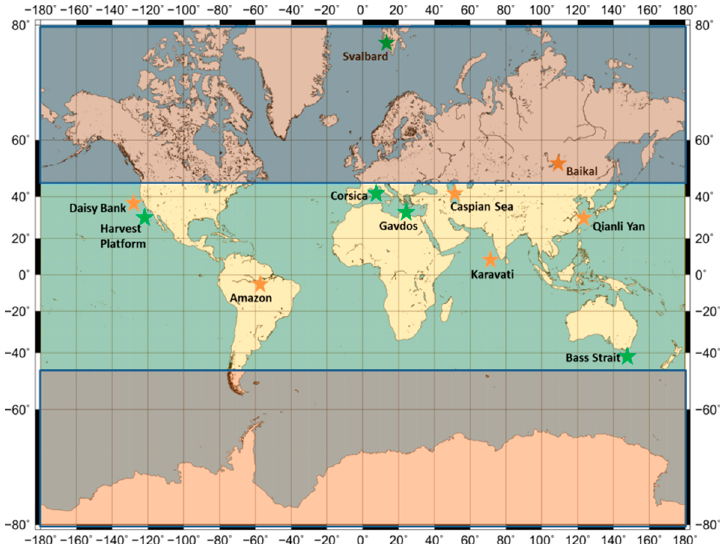
Figure 2. International permanent (green star) and temporary (orange star) satellite altimetry Calibration/Validation (Cal/Val) sites. Cal/Val sites are distributed at present mainly within the [ − 45 o + 45 o ] latitude zone.